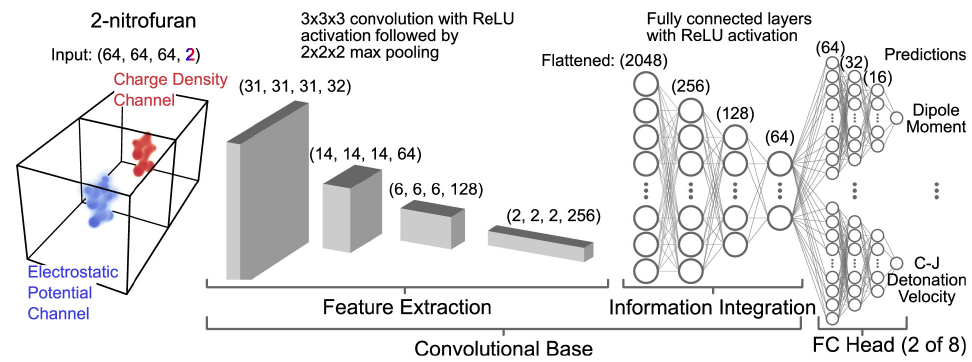
Figure 8. Selected model architecture. An example molecule, 2-nitrofuran, is represented by a standardized input [65]. Copyright 2020 American Chemical Society.